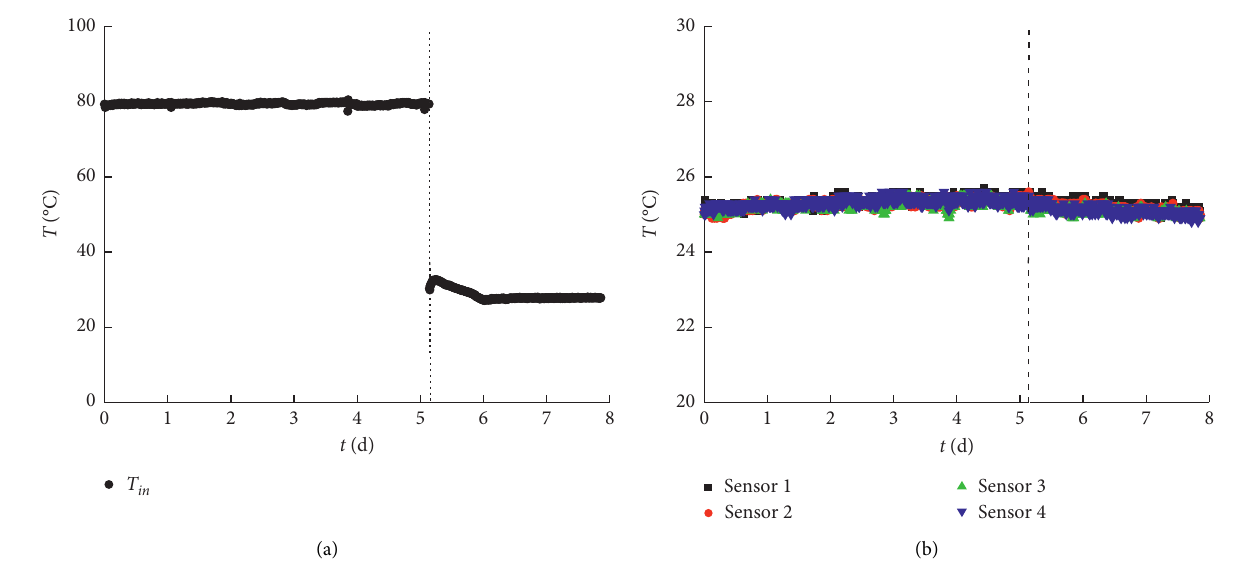
Figure 3: Variation of (a) heat source temperature and (b) boundary temperature with